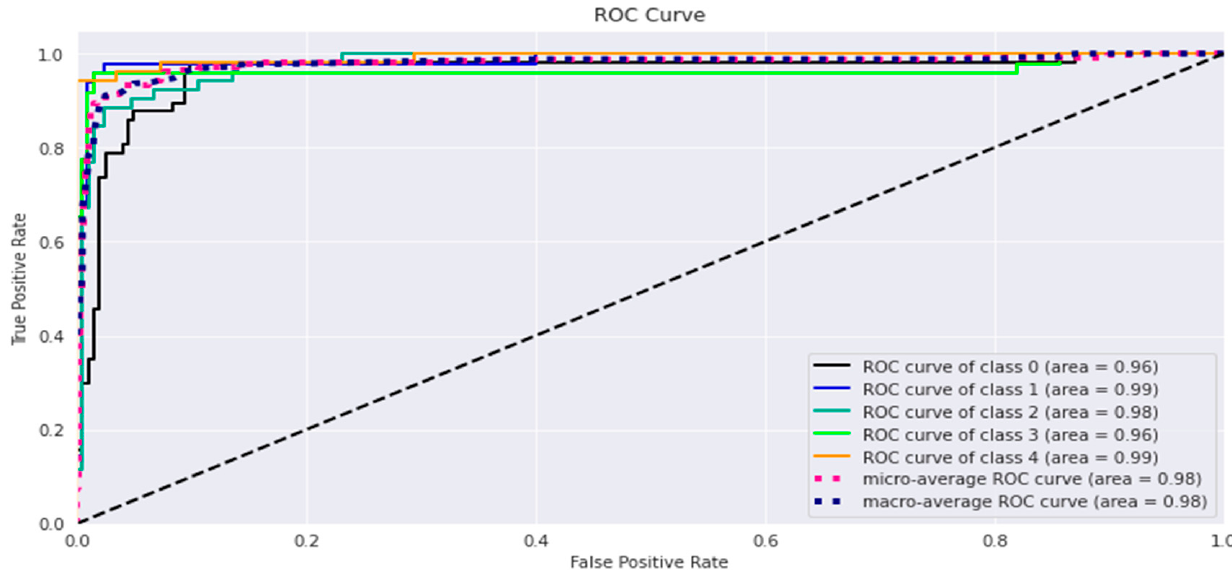
Figure 14. Region of convergence of 3*3 configuration.